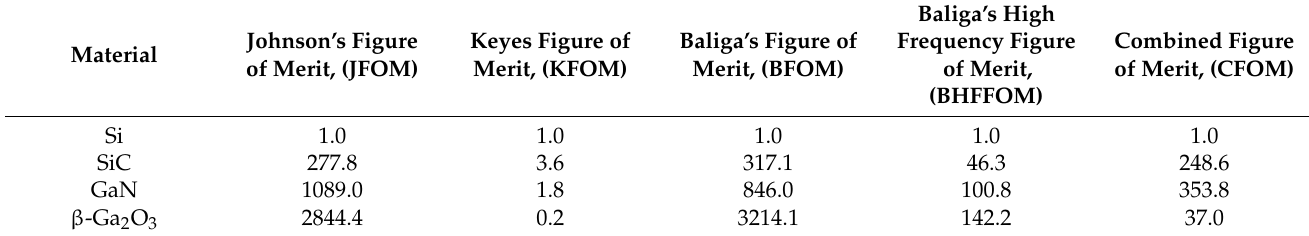
Table 1. Figures of merit of GaN and competing semiconductor materials in power electronics